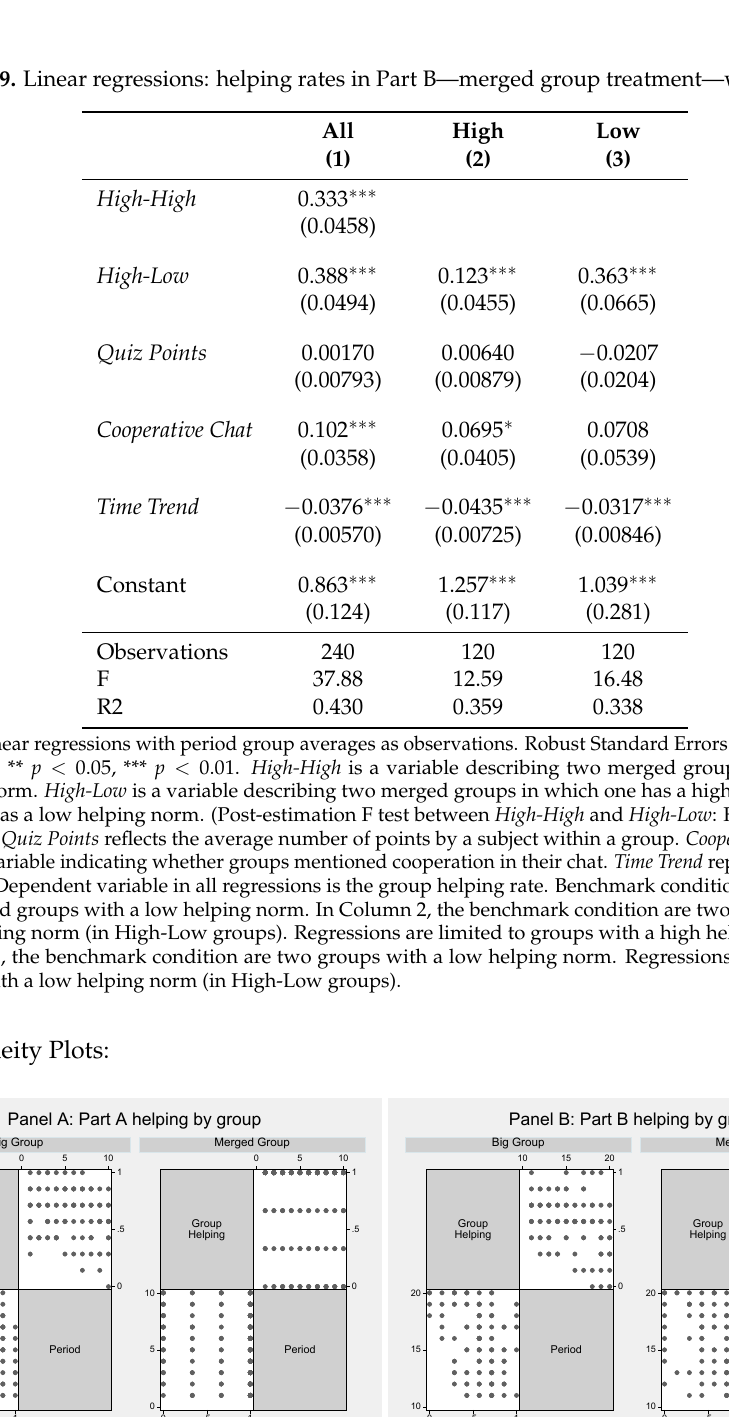
Graphs by (mean) treatment